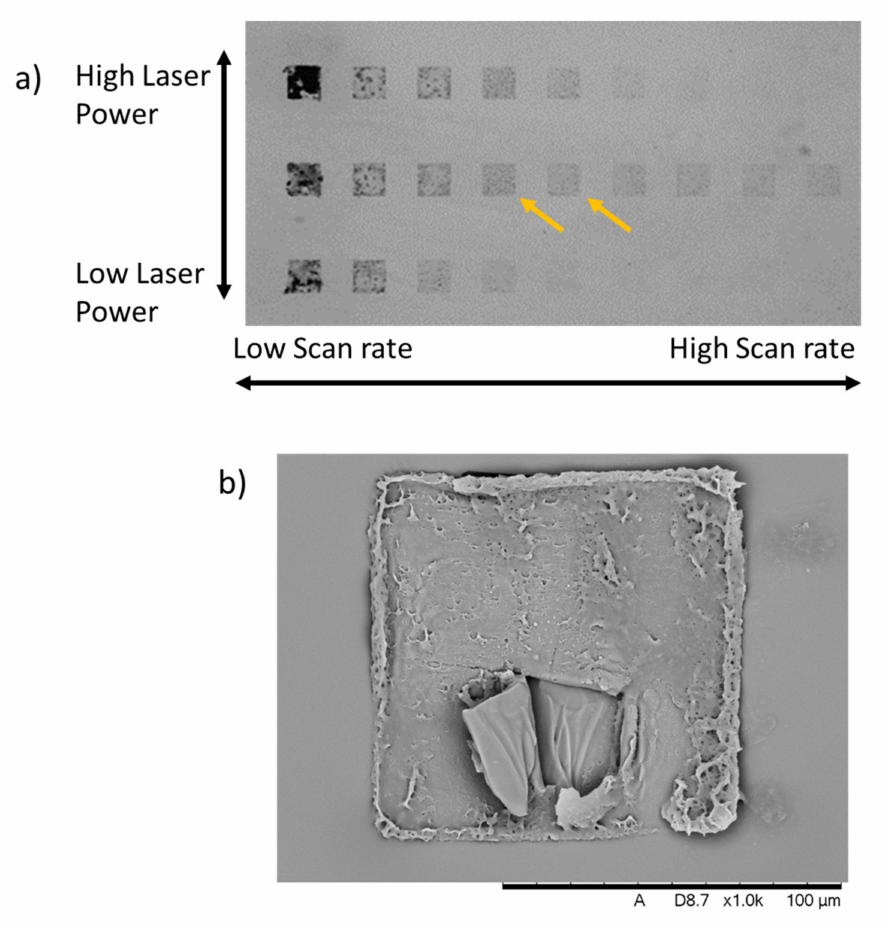
Figure 5. ( a ) Optimisation conditions of MWCNTs-GelMa inks to produced thin-films by 2PP. Laser power was varied between 50, 40 and 30 mW and the scan rate was varied between 500, 1000, 2000, 5000, 10,000, 20,000, 30,000, 40,000 and 50,000 µ m/s. Layer distance corresponds to 0.3 µ m. Hatch spacing corresponds to 0.2 µ m. Yellow arrow indicates our selected optimal conditions. ( b ) SEM image of dehydrated MWCNTs-GelMa thin-film manufactured by